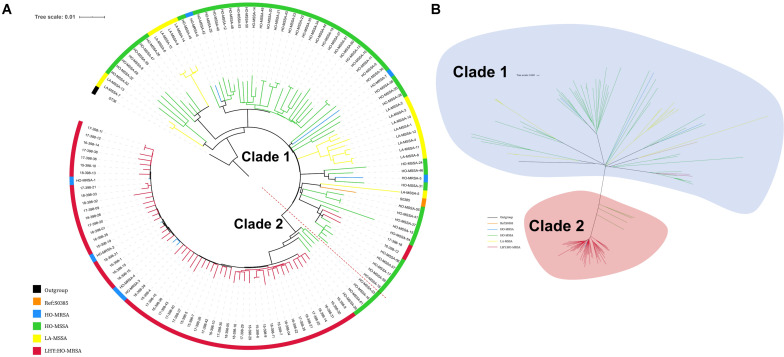
Phylogenetic structure of ST398 S. aureus isolates. (A) Maximum-likelihood phylogenetic tree of ST398. A total of 129 S. aureus ST398 isolates (114 from adult patients and 15 from livestock) were used for phylogenetic reconstruction. Relationships are shown with respect to the genome of the standard LA-MRSA strain (S0385). Branches are colored by geographic origin of isolates. The tree is rooted with ST36 as an outgroup. (B) Unrooted tree of ST398 S. aureus isolates. Branches in this tree could be classified into two main clades, including Clade I and Clade II. Branches are colored by geographic origin of isolates. Black branch: outgroup. Orange branch: reference isolate. Blue branch: human-adapted (HO-MRSA) isolates sequenced in our previous study. Green branch: HO-MSSA isolates in our previous study. Yellow branch: livestock-adapted (LA-MSSA) isolates in our previous study. Red branch: HO-MRSA isolates sequenced in this study.